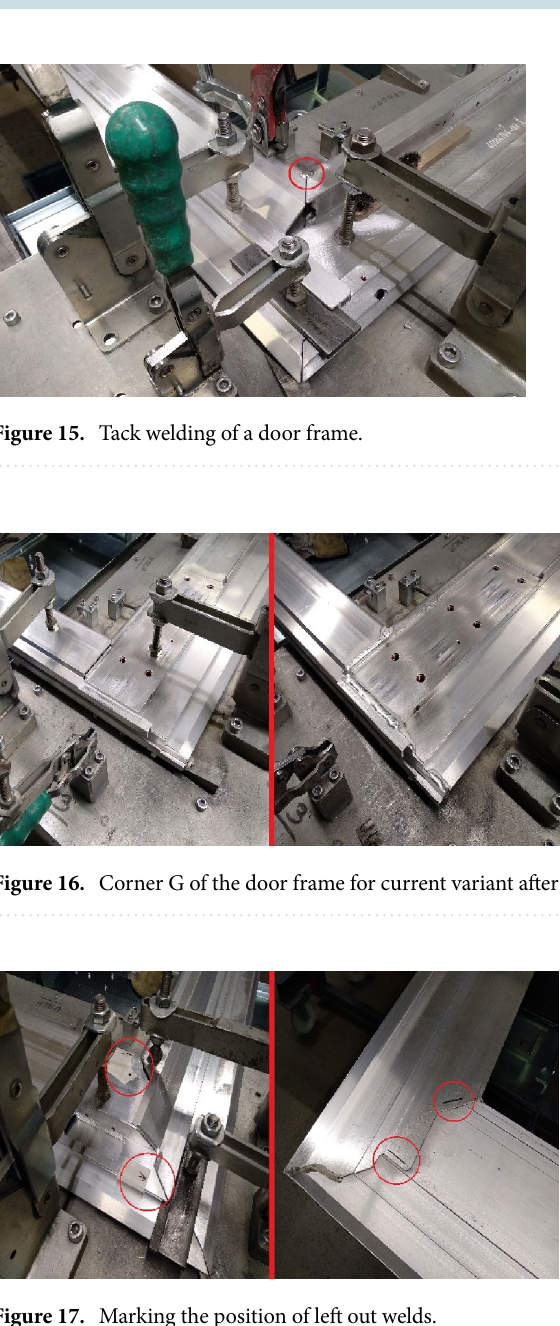
Figure 17. Marking the position of left out